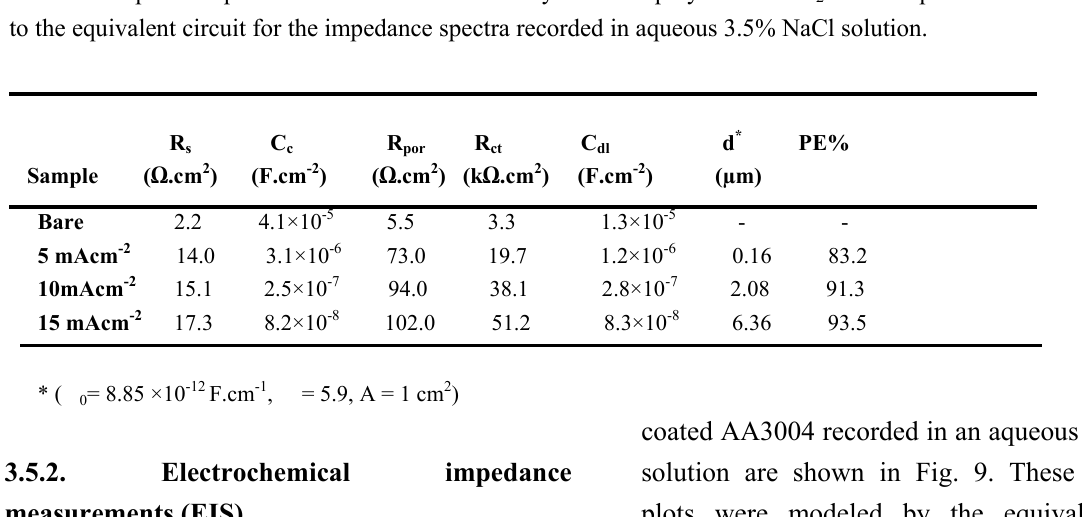
nanocomposite extracted from the fit 2